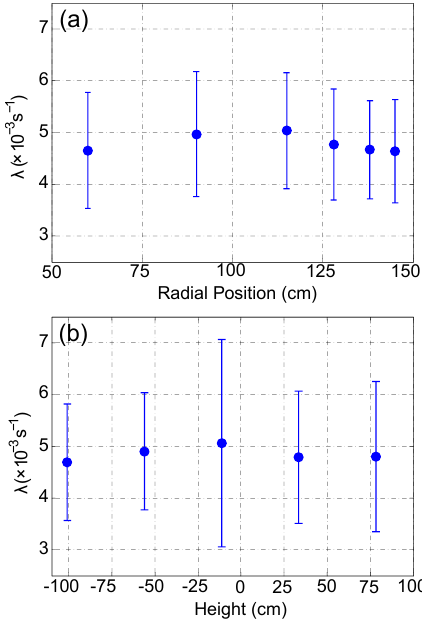
Figure 8. Air reheating rates ( λ ) following an adiabatic pressure re- duction versus (a) radial and (b) vertical positions in the chamber. The data points show the mean and standard deviations of the air reheating rates obtained for 300 expansions in the CLOUD9 cam- paign.